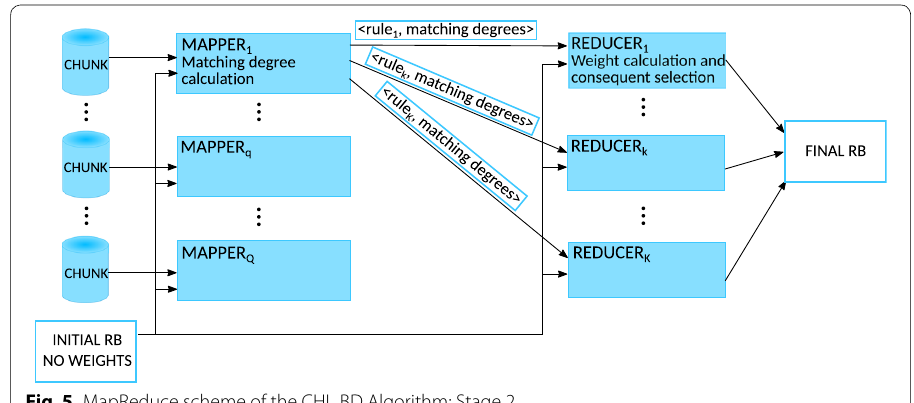
Fig. 5 MapReduce scheme of the CHI_BD Algorithm: Stage